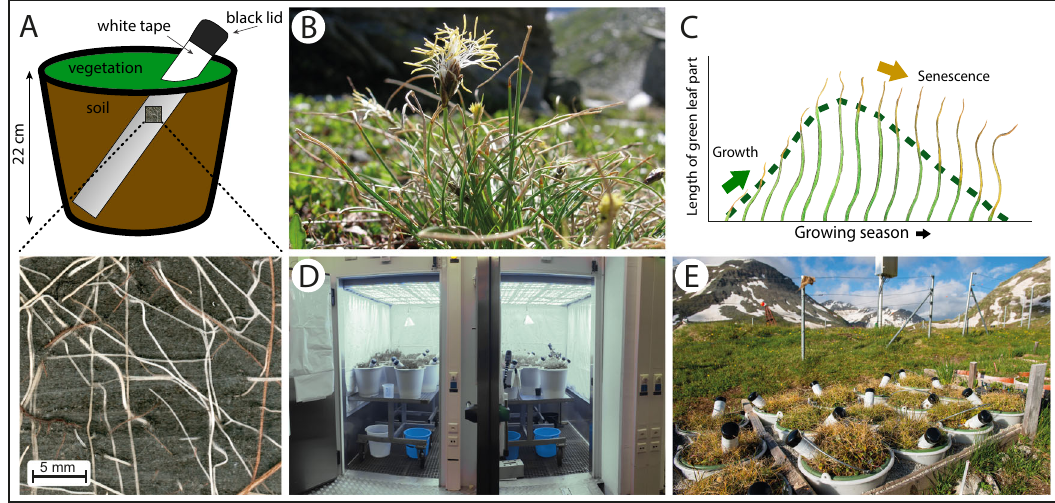
Fig. 1| Overviewoftheexperimentalsetup.A Schemeofamonolithwith natural vegetation and its originalsoil, equippedwith a transparent rhizotron tube to scan rootgrowth.Rootsgrowalongthetubesurface(seeinsertbelow). B Thedominant species Carex curvula . Photo: C. Körner. C Elongation and browning of a single